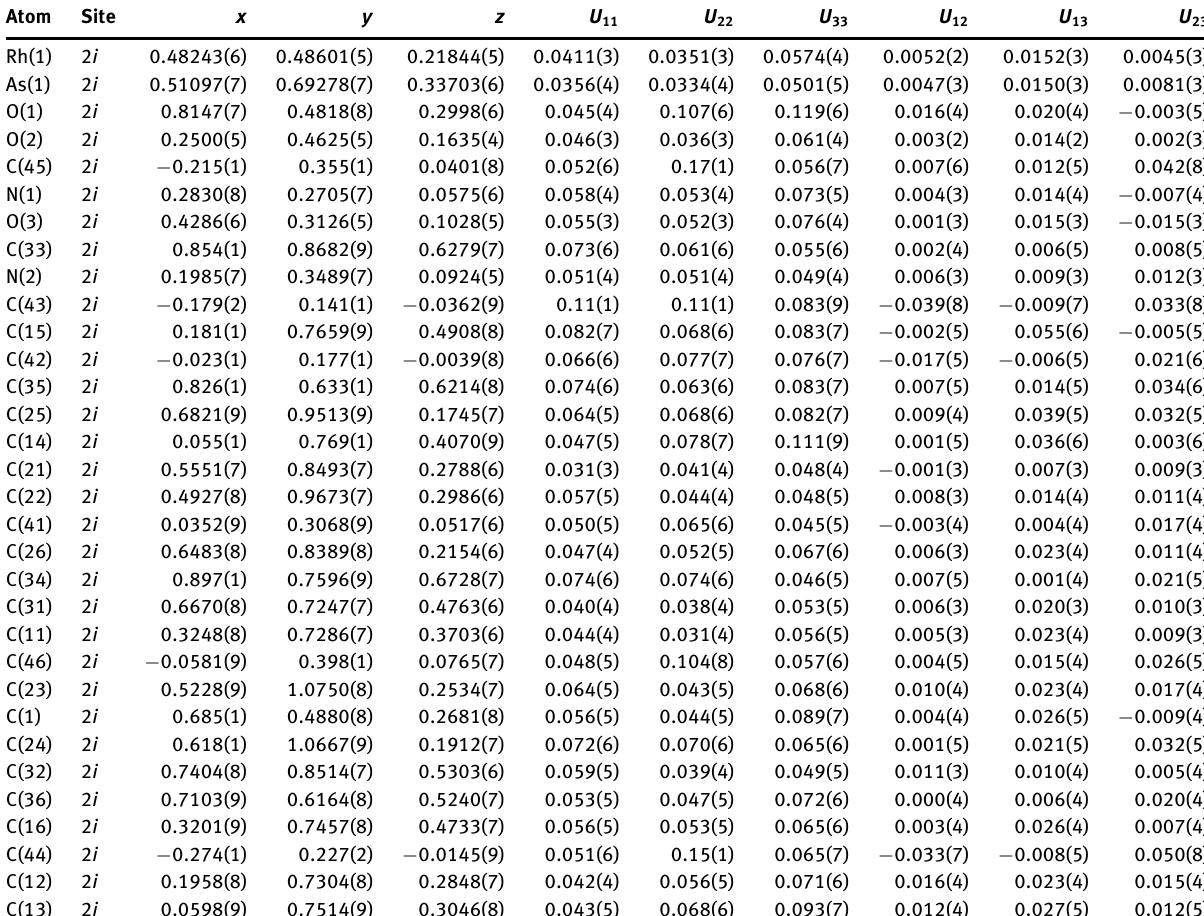
Table 3: Atomic displacement parameters (Å 2